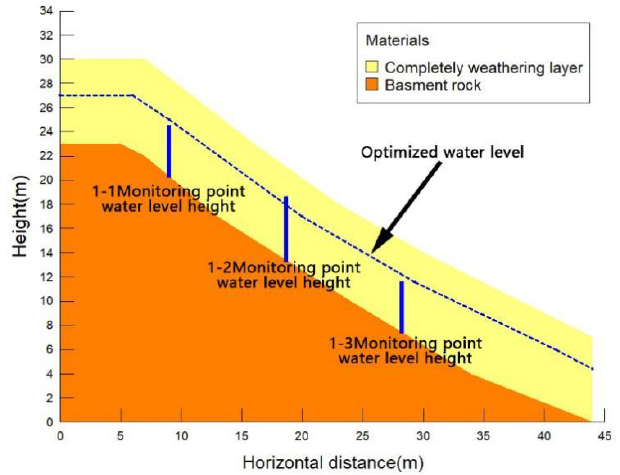
Figure 4. Variation in water level at different points on the same line of a rare earth slope with time.